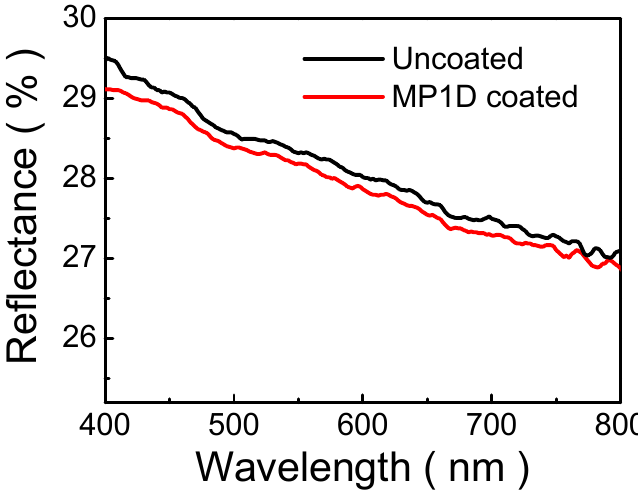
Figure 2. Reflectance spectra of MP1D film on ITO glass.